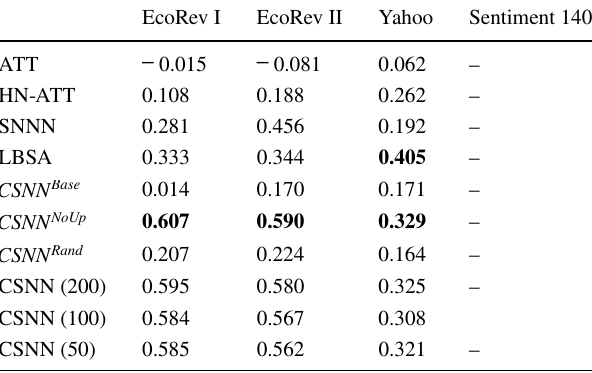
Best scores are in